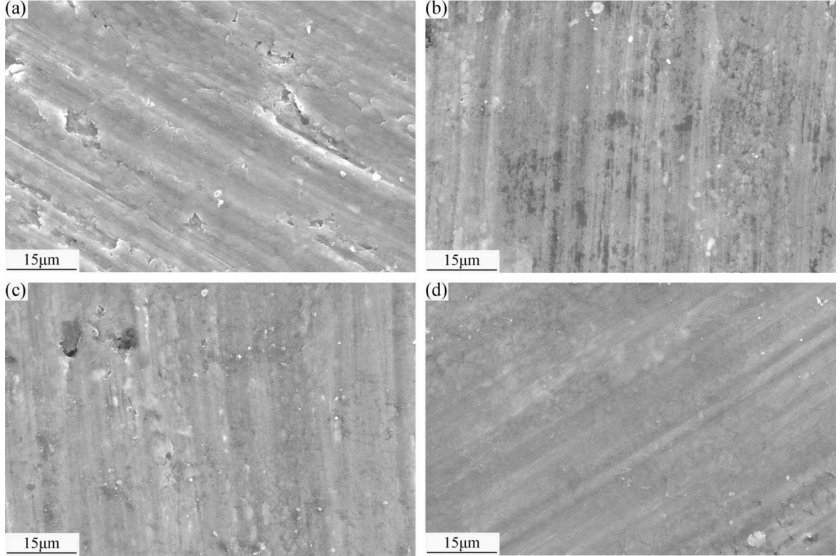
Figure 11. SEM images of the worn surfaces of the composites after the T6 heat treatment: ( a ) Al6061 alloy; ( b ) Cu-Cf / Al; ( c ) Ni-Cf / Al; and ( d ) Cu-Ni-Cf /